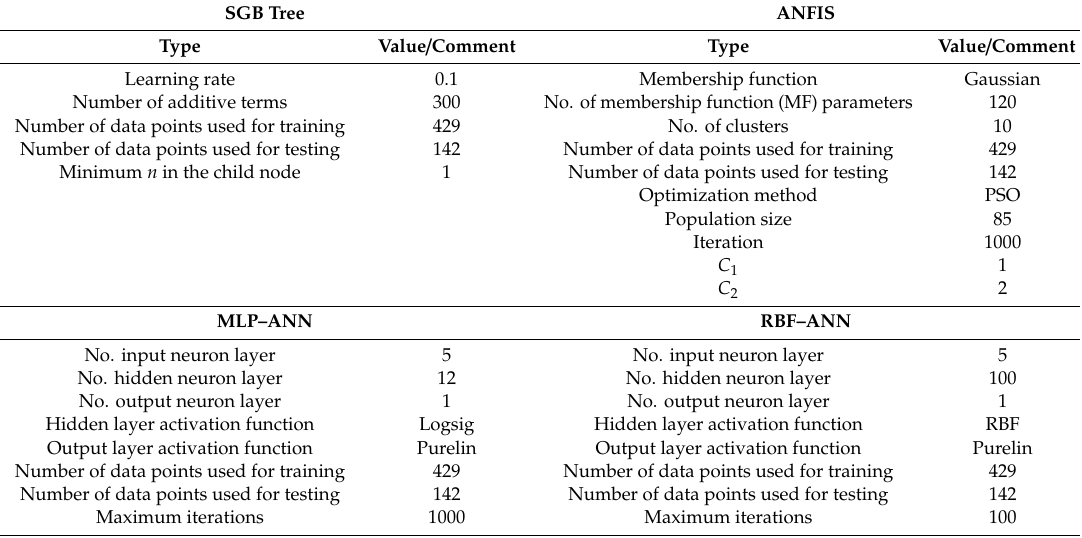
Table 2. More details of trained models for the prediction of the C p s of the ILs.